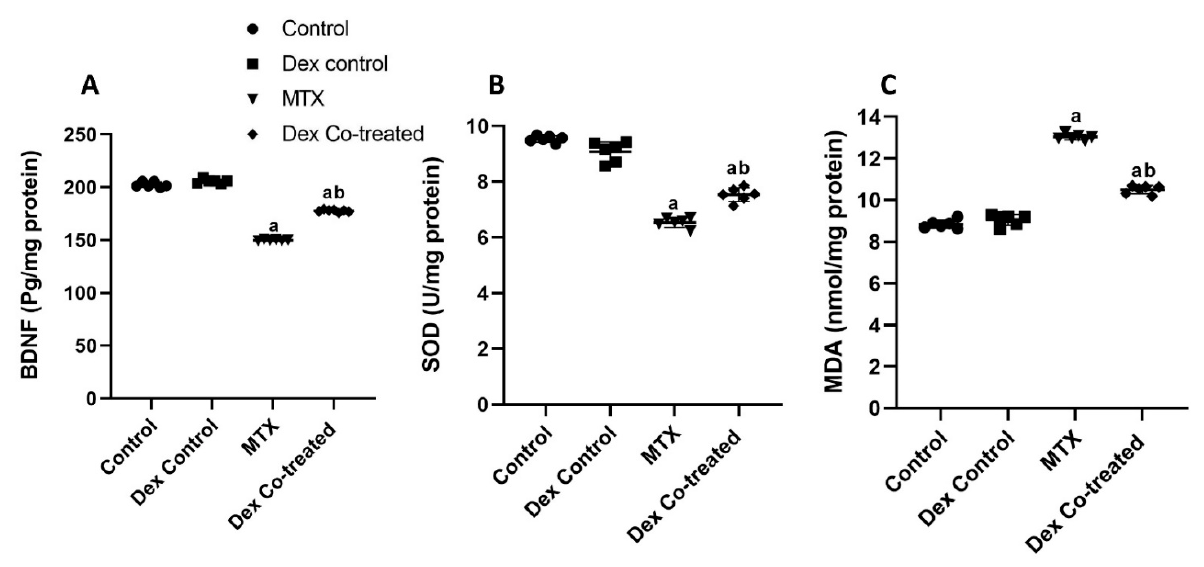
Figure 3. Effects of MTX and Dex co-treatment on expression of BDNF and oxidative stress markers. ( A ) MTX induces a significant decrease in BDNF expression level when compared to the